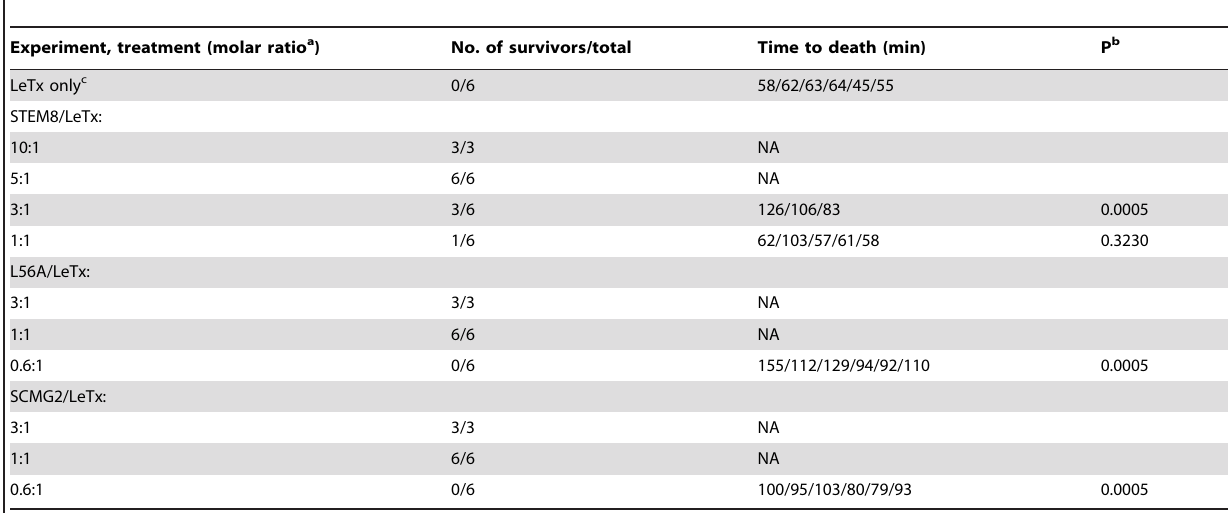
Experiment, treatment (molar ratio a